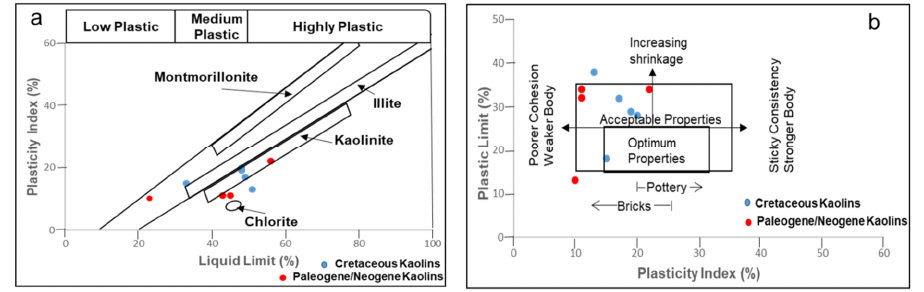
Figure 8. Position of the studied Cretaceous-Paleogene/Neogene kaolins on the Holtz and Kovacs [31] diagram ( a ) and clay workability chart (After [17]) ( b ).